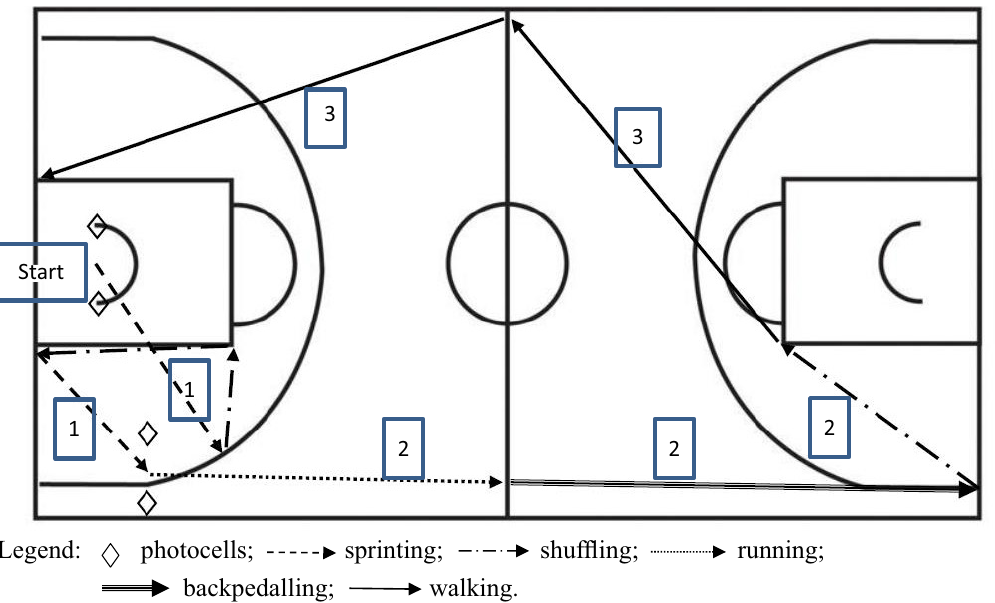
Figure 1. Measured sections of BSFP